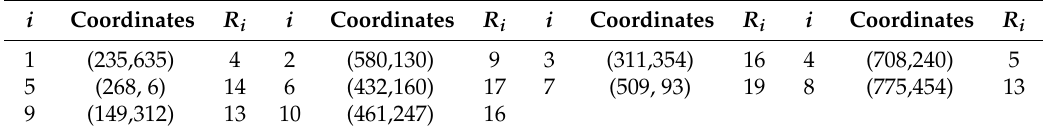
Figure 5. Two optimal traveling paths for the 10-node and 50-node sensor network. Table 2. The coordinates (in m ) and the R i (in kb / s ) of each node in the network.